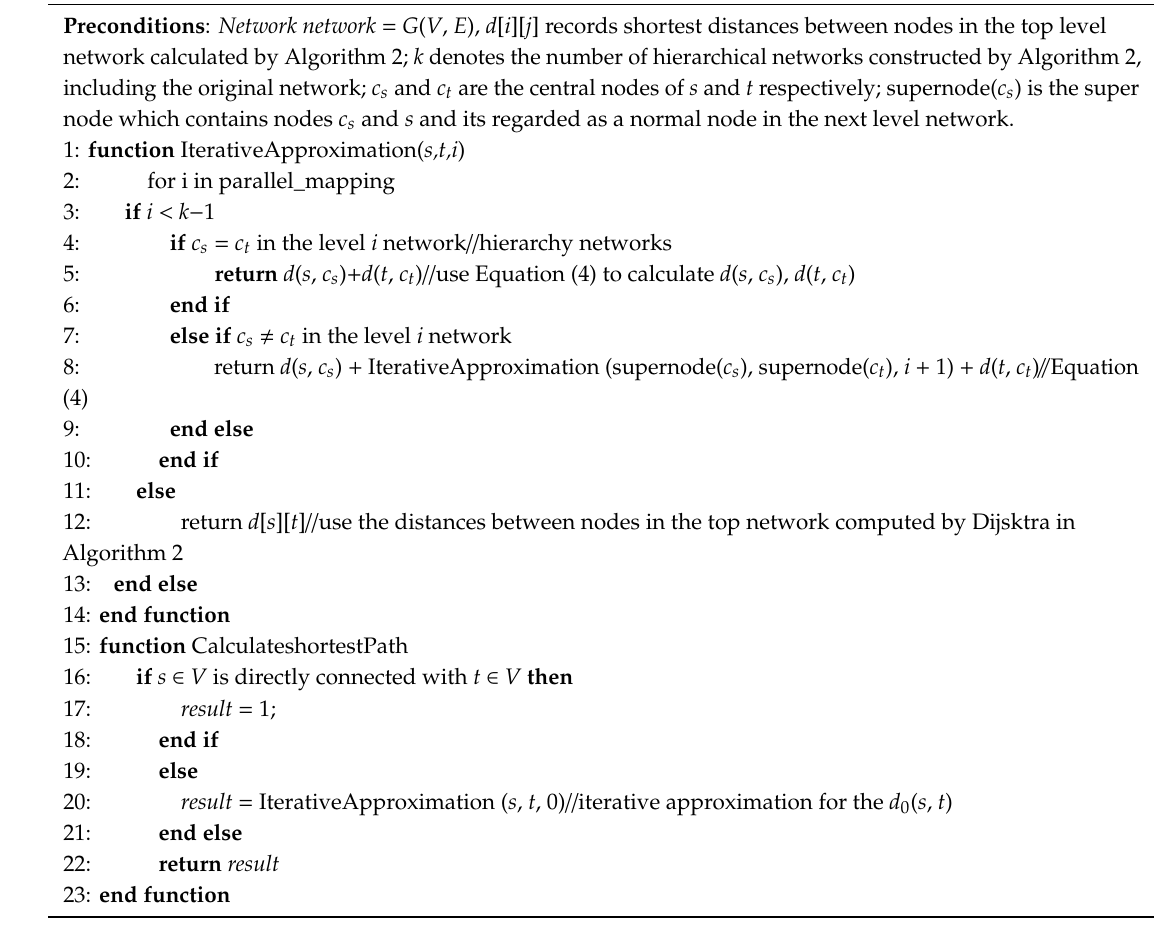
Algorithm 4. Calculate Shortest